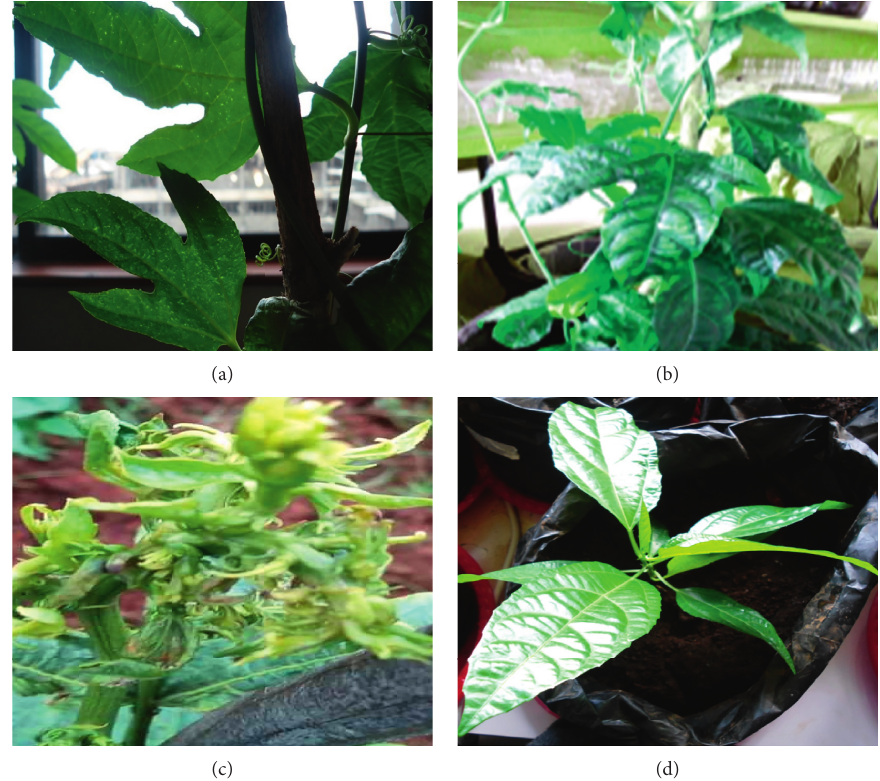
Figure 2: Foliar symptoms at eight weeks after inoculation. Diffused leaf mosaic by CABMV isolate 2 (a), concentrated mosaic, rugose leaf, vein clearing, and deformed leaves by CABMV isolate 1 (b), leaf curl, whole leaf mosaic, leaf deformation, blisters formation, and leaf roll by dual infected virus isolates (c), and healthy plant